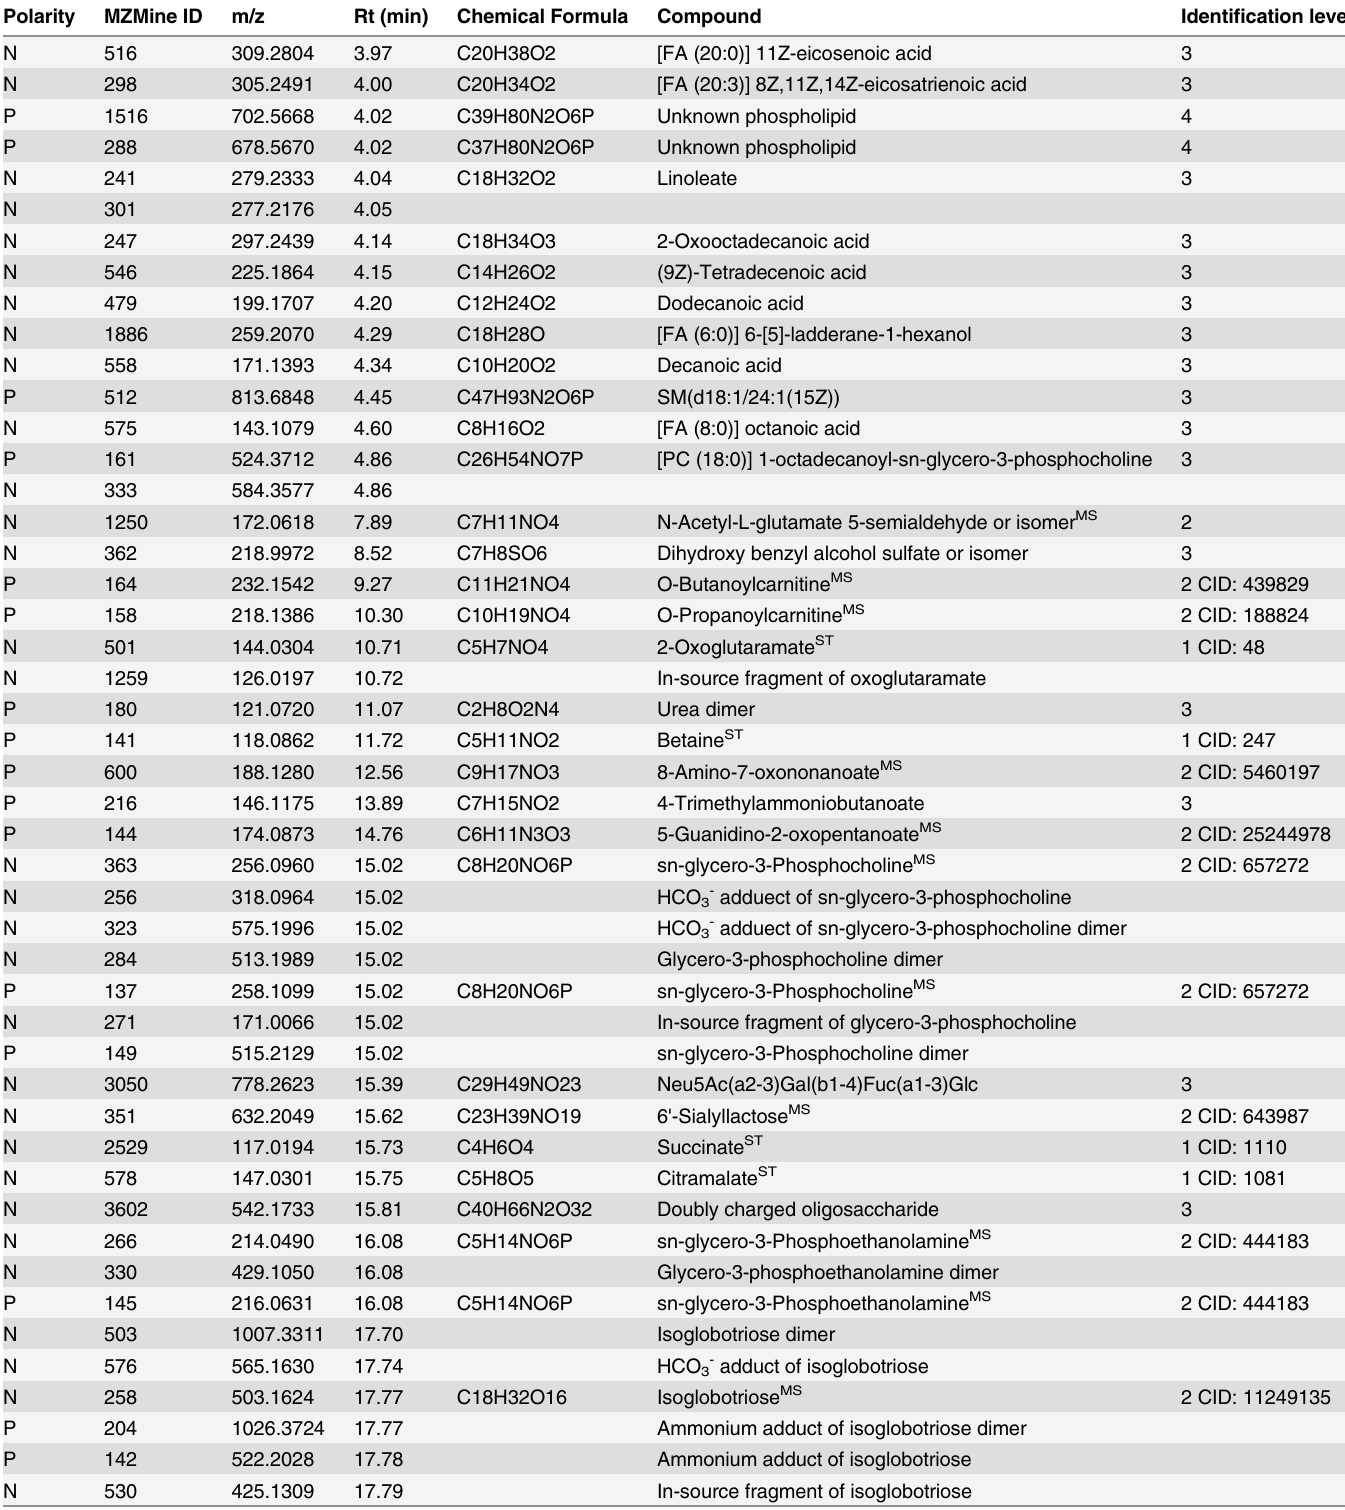
Table 3. Compounds in giant panda milk tentatively correlated with cub growth